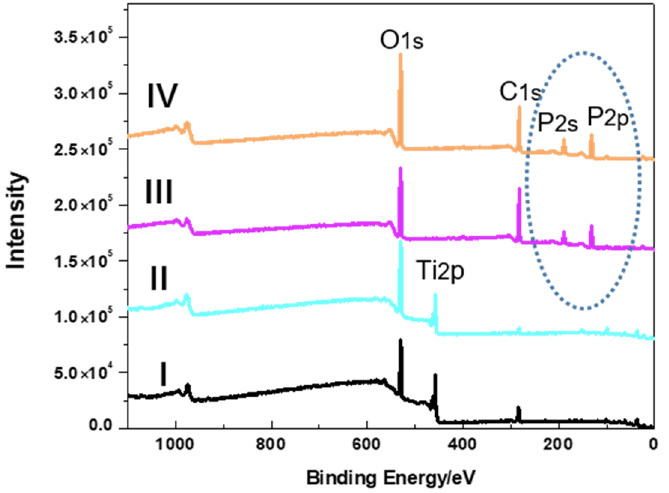
Figure 7. XPS survey scans of I: bare Ti6Al4V, II: Ti6Al4V heat treated at 300 ◦ C, III: organic PVPA-coated Ti6Al4V, and IV: inorganic thermal oxide/organic PVPA composite-coated Ti6Al4V. Nanoindentation was performed on the sample to determine the elastic modulus, as shown in Figure 8. The elastic modulus of the organic PVPA-coated Ti6Al4V was 11.2 ± 0.2 GPa, which corresponds to a stress of 21.42 MPa at 2.5N.